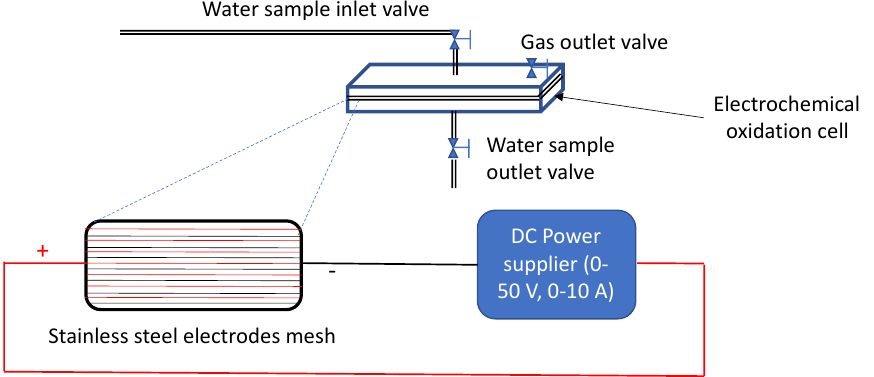
Figure 1. Experimental device: electrochemical oxidation cell with stainless-steel electrodes.